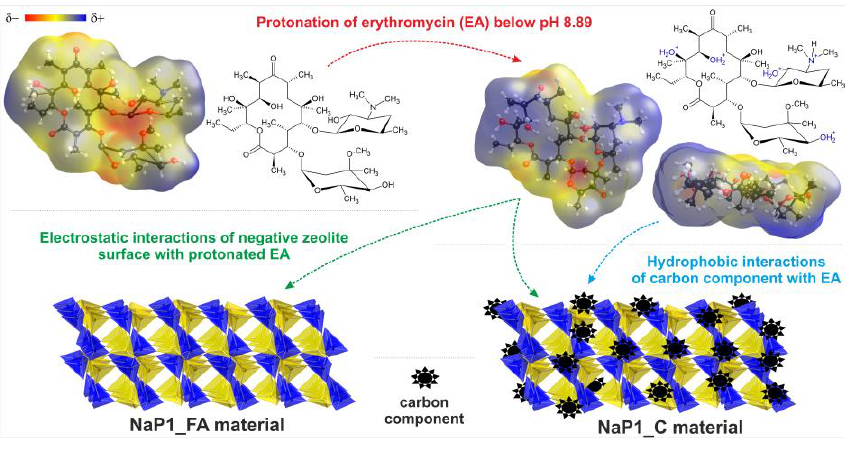
Figure 7. Possible interactions of erythromycin with zeolitic materials.